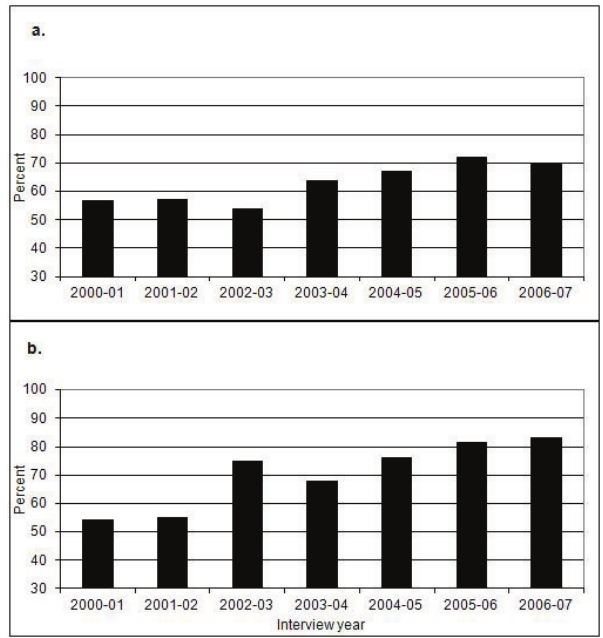
Fig. 2. Percent of respondents that met their Porcupine caribou needs in fall (a) and spring (b), 2000–2007, based on interviews in user